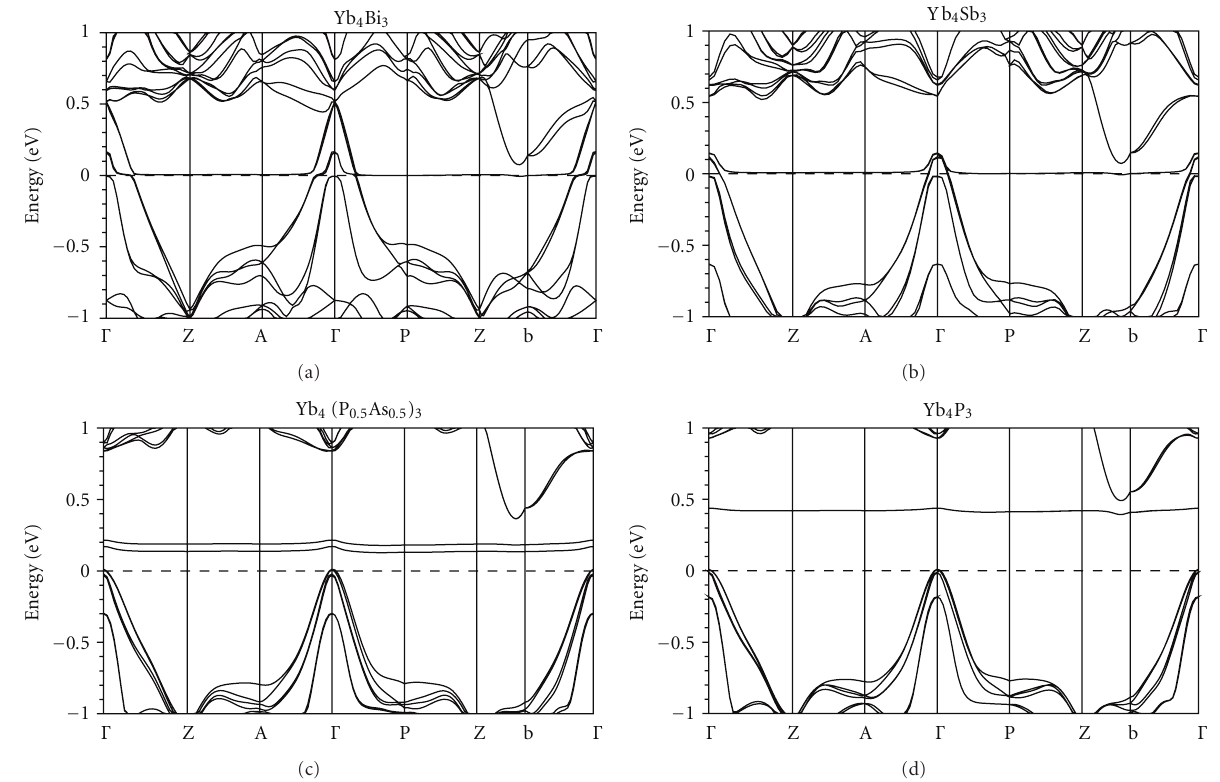
= 9 . 6 eV) energy band structure of Yb e ff